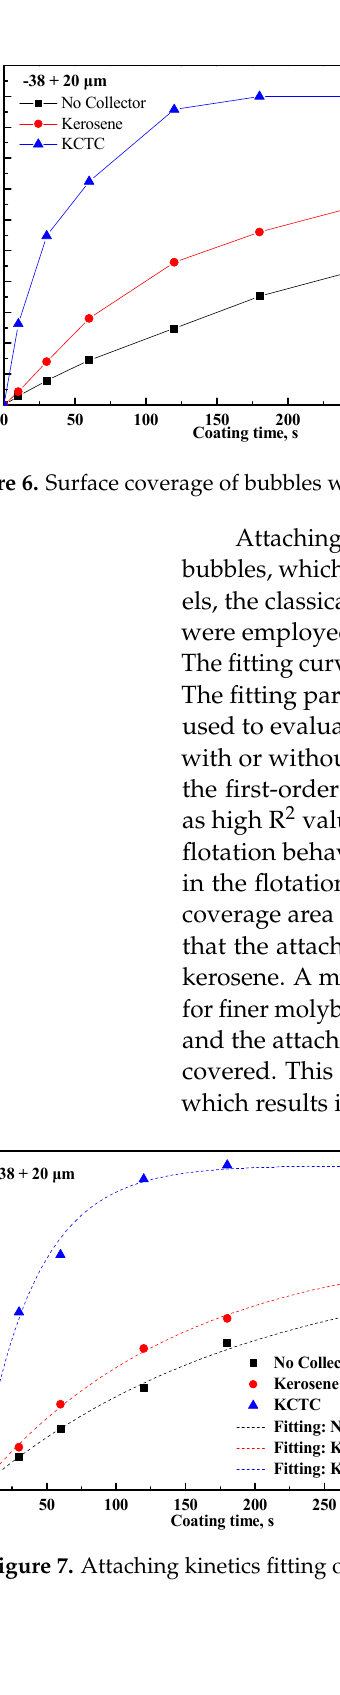
Figure 8. Attaching kinetics fitting of molybdenite particles to bubbles, using a first ‐ order model with a rectangular distribution. Figure 7. Attaching kinetics fitting of molybdenite particles to bubbles, using a classical first ‐ order model.